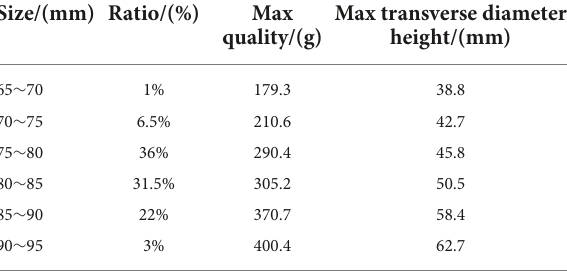
TABLE 1 Test results of geometry and mass.